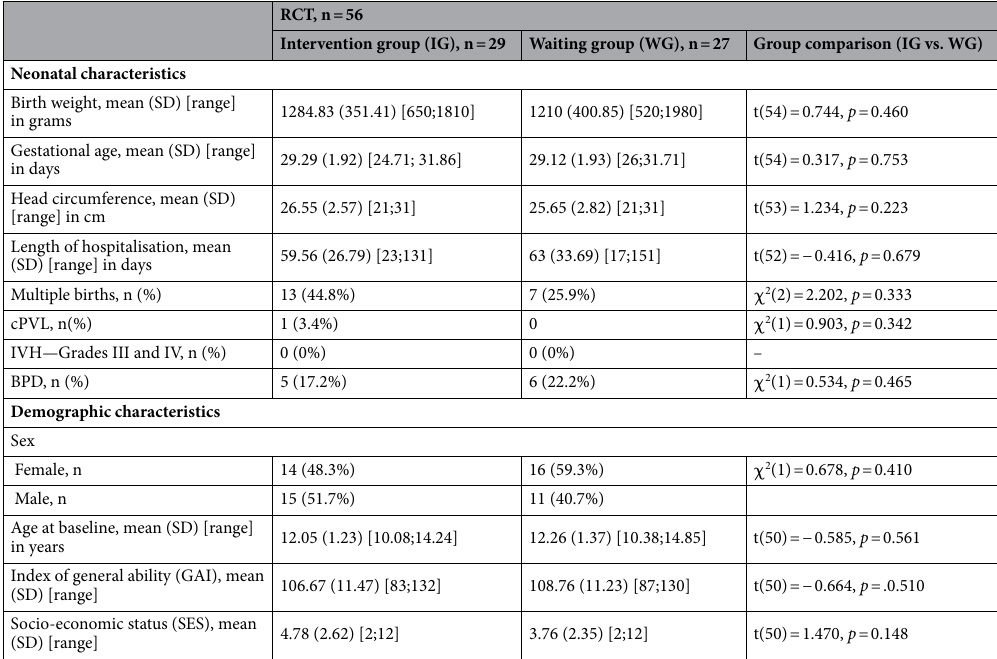
Table 1. Neonatal and demographic characteristics at baseline of young adolescents enrolled in the RCT (n = 56), as well intervention group (IG) and waiting group (WG) comparisons. Sex refers here to the individual’s physical characteristics at birth associated with male or female. Independent-sample t-test, Chi-square was used to compare the randomised group. cPVL cystic periventricular leukomalacia, IVH Intraventricular haemorrhage, BPD Bronchopulmonary